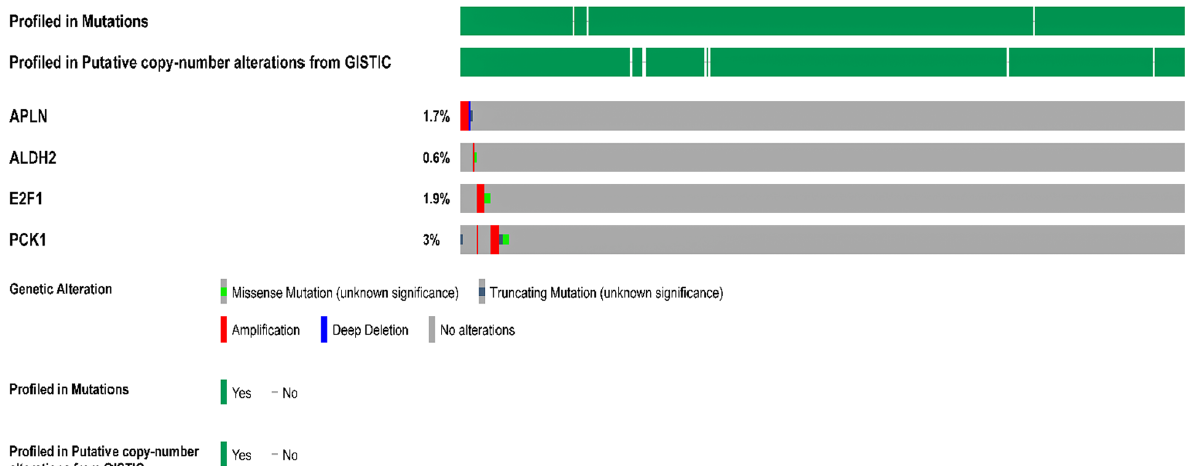
Fig. 6 OncoPrint summarizes genomic alterations in key adipokines and adipogenesis across TCGA-HCC cohort comprising 363 samples. The bottom row represents frequency of genomic alterations in APLN, ALDH2, E2F1, PCK1 with red, blue, green, and gray bars signifying amplifications, deep deletions, missense and truncating mutations, respectively